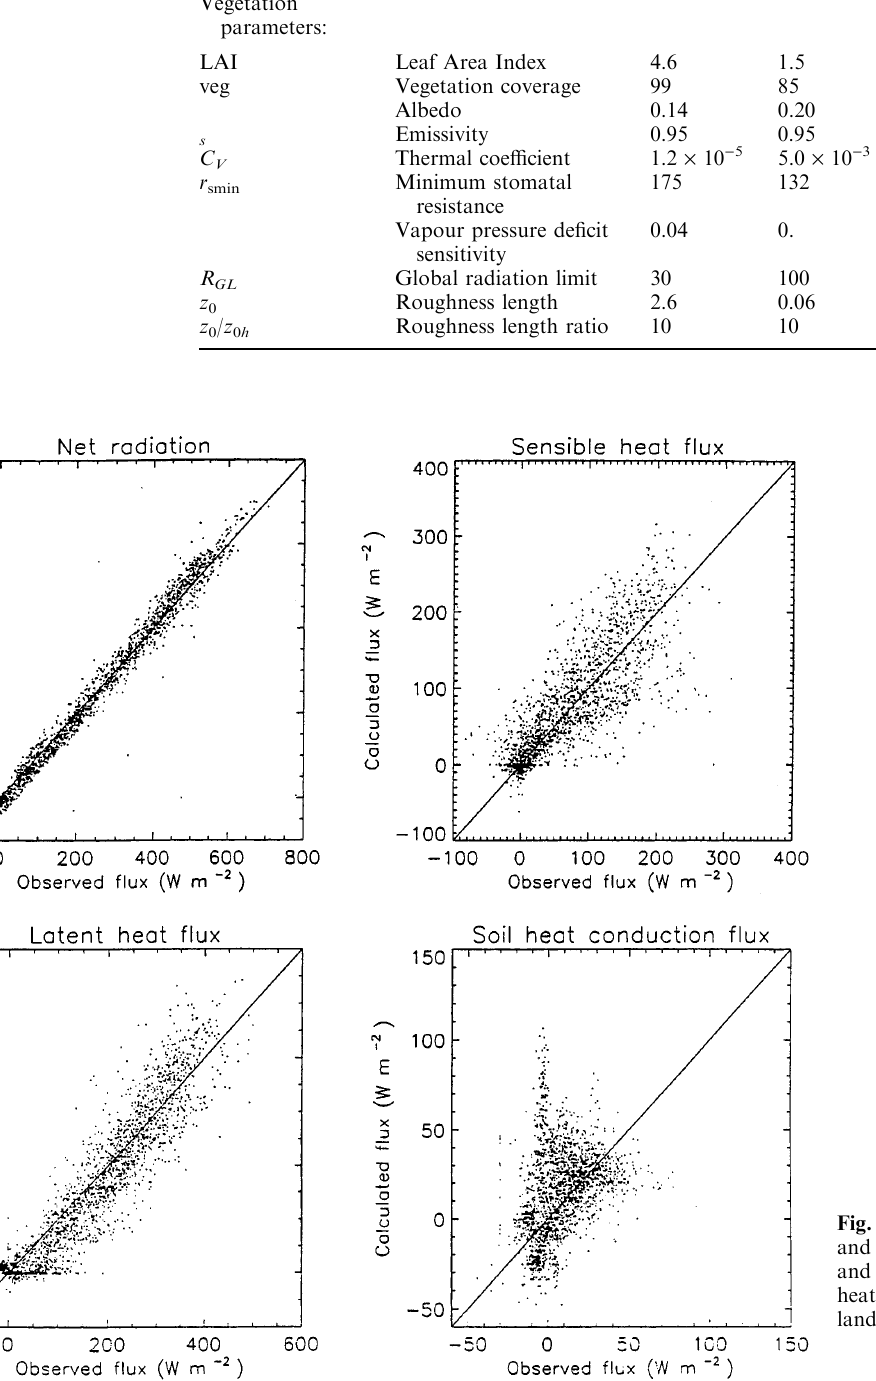
Fig. 5. Comparison of modelled and observed net radiation, latent and sensible heat flux and soil heat flux for forest for the ISBA land